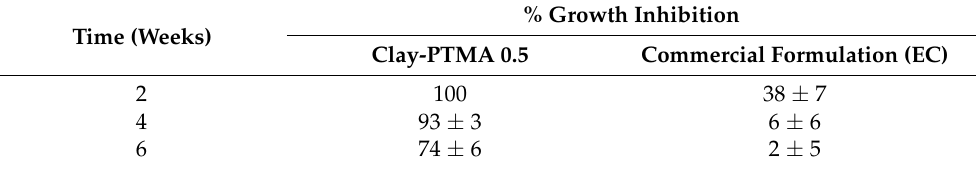
Table 3. Effect of acetochlor formulations on growth inhibition of the test plant green foxtail in soil taken from the upper 5 cm of soil in a field experiment in Rehovot as determined weeks after application. % Growth Inhibition Time (Weeks) Clay-PTMA 0.5 Commercial Formulation (EC) 2 100 38 ± 7 4 93 ± 3 6 ± 6 6 74 ± 6 2 ±